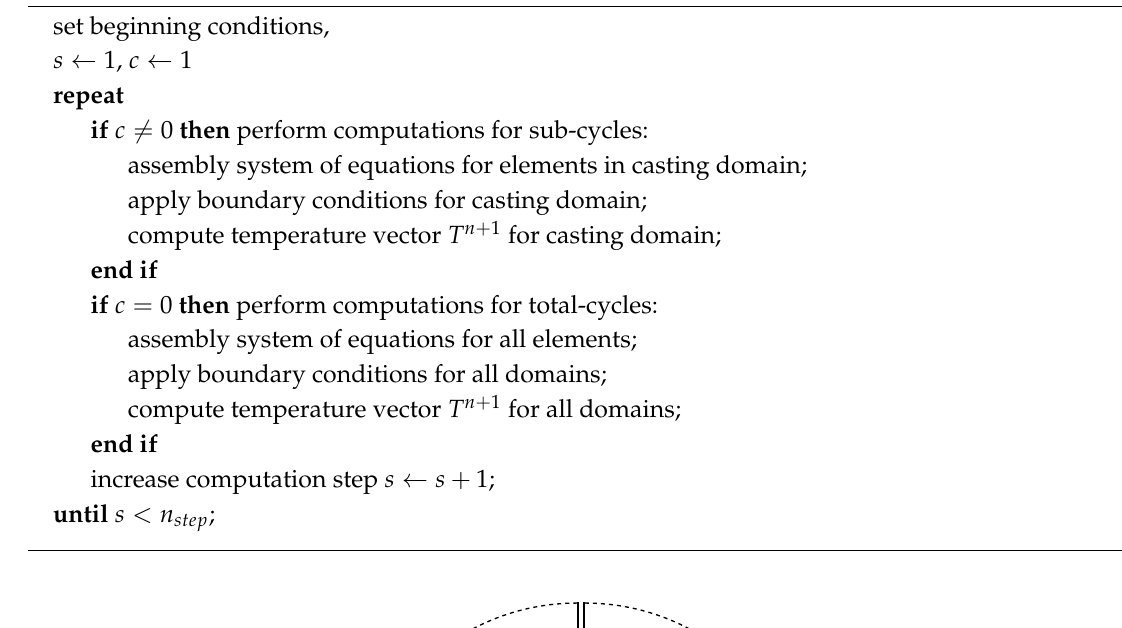
Algorithm 1 Protocol of computations